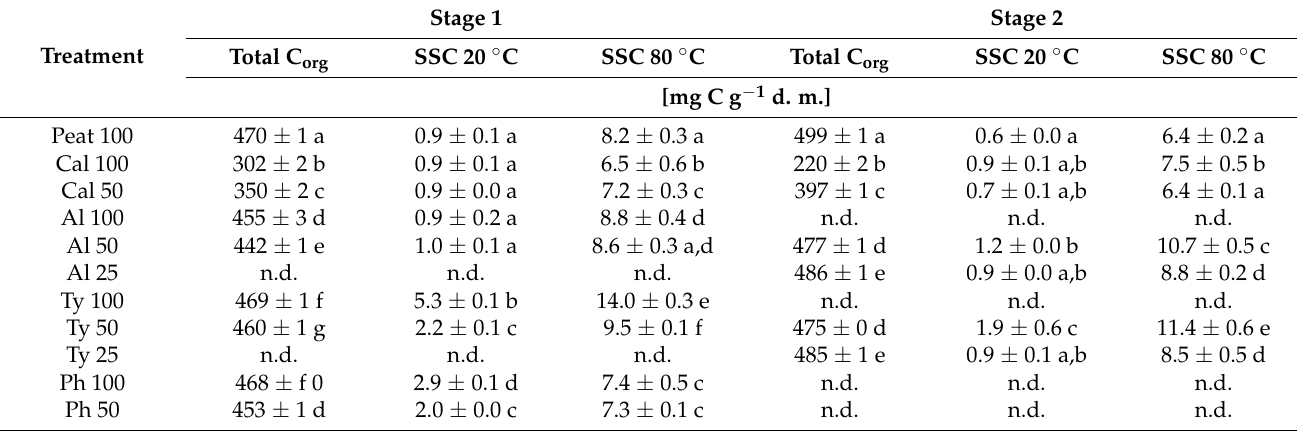
Table 6. Content of salt-extractable C compounds of the different treatments at 20 and 80 ◦ C in stage 1 and stage 2. n = 4, variance analysis: Kruskal–Wallis, post hoc test: pairwise t test, p < 0.05. C org : organic carbon, SSC: salt-soluble carbon, d.m.: dry matter. Different letters indicate significant differences among treatments. Explanation of treatment names see Table 1. Stage 1 Stage Treatment